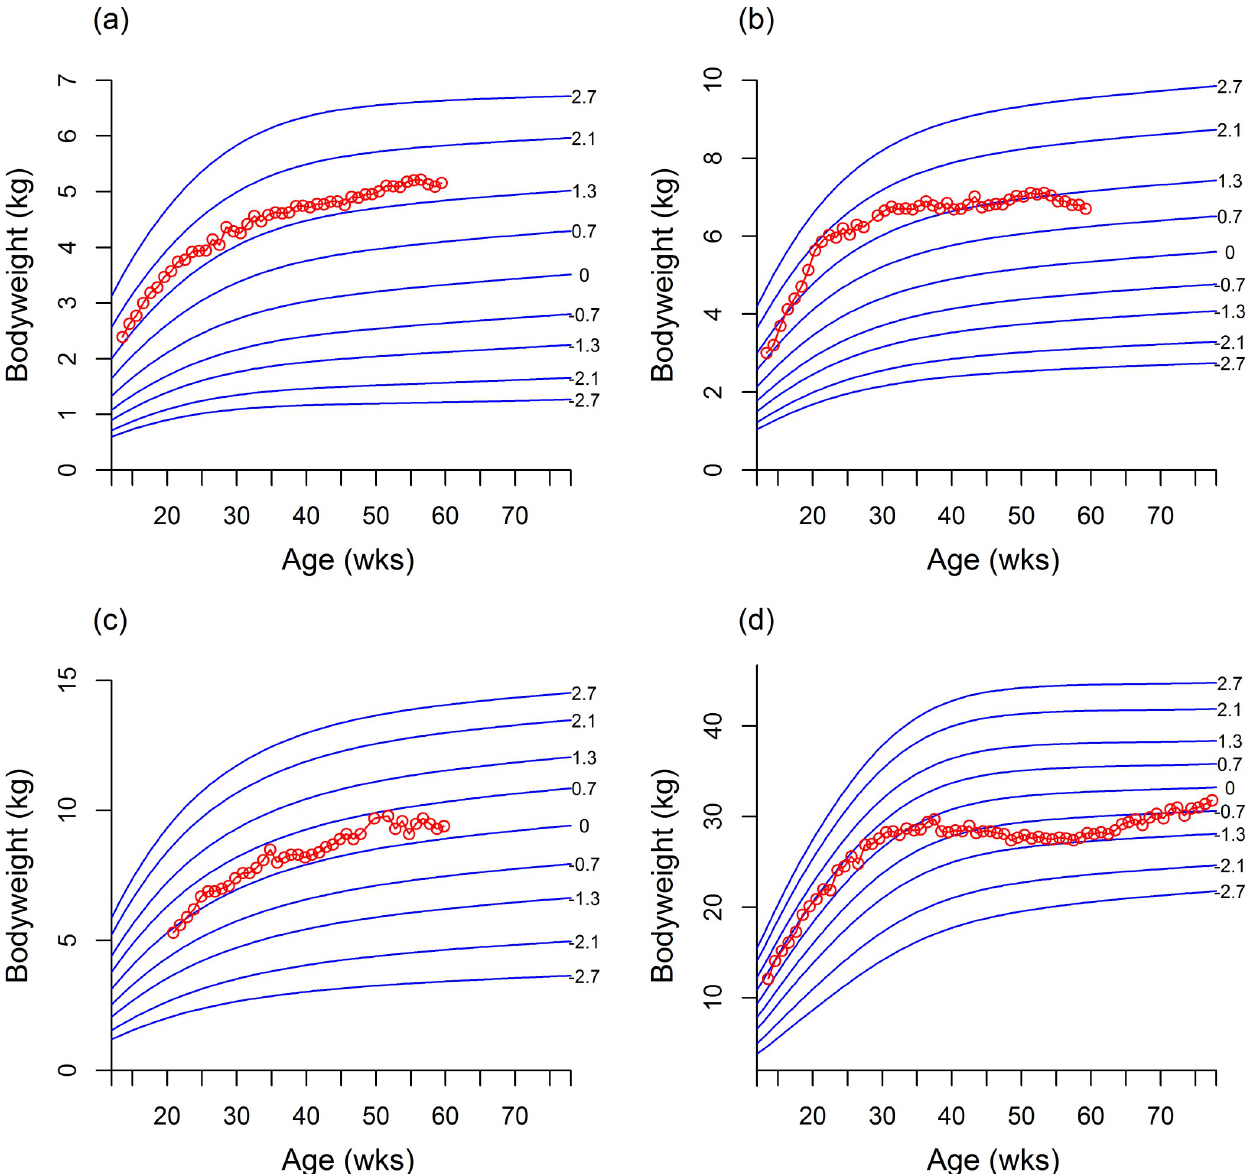
Fig 2. Examples of individual growth trajectories from healthy dogs plotted onto the growth curves. The red open circles represent separate weight measurements for the same dog, whilst the solid blue lines represent the growth curves for the respective breed size category. (a) The growth curve of a male Yorkshire terrier which closely followed the centile lines. (b and c) Growth curves of a female Miniature Schnauzer (b) and a female Cocker Spaniel (c) whose growth pattern followed the centile lines relatively well. (d) Growth curve of a male Labrador retriever whose pattern of growth showed some differences from the centile lines, as indicated by some centile line